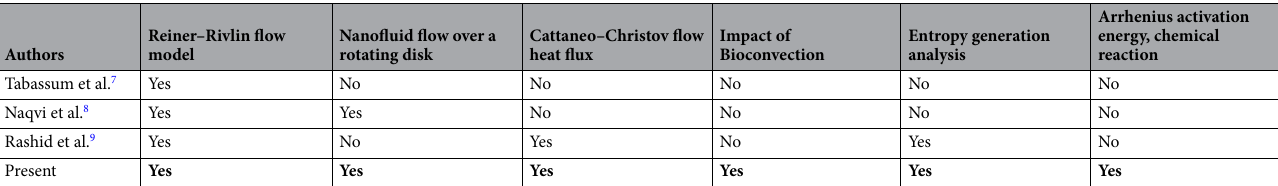
Table 1. Literature survey for novelty of the envisioned